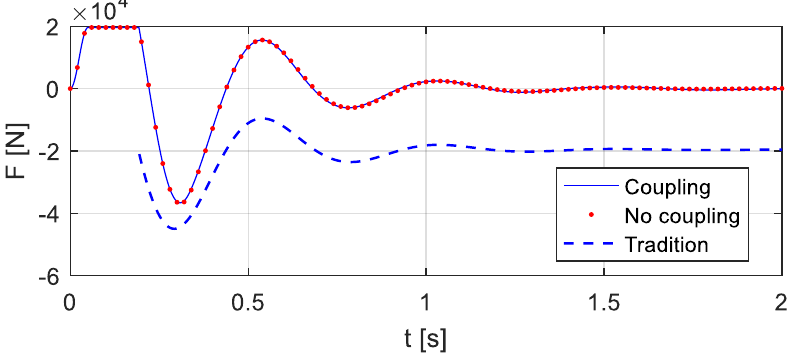
Figure 10. Relative velocity v c ( t ) between the vehicle and the bridge.